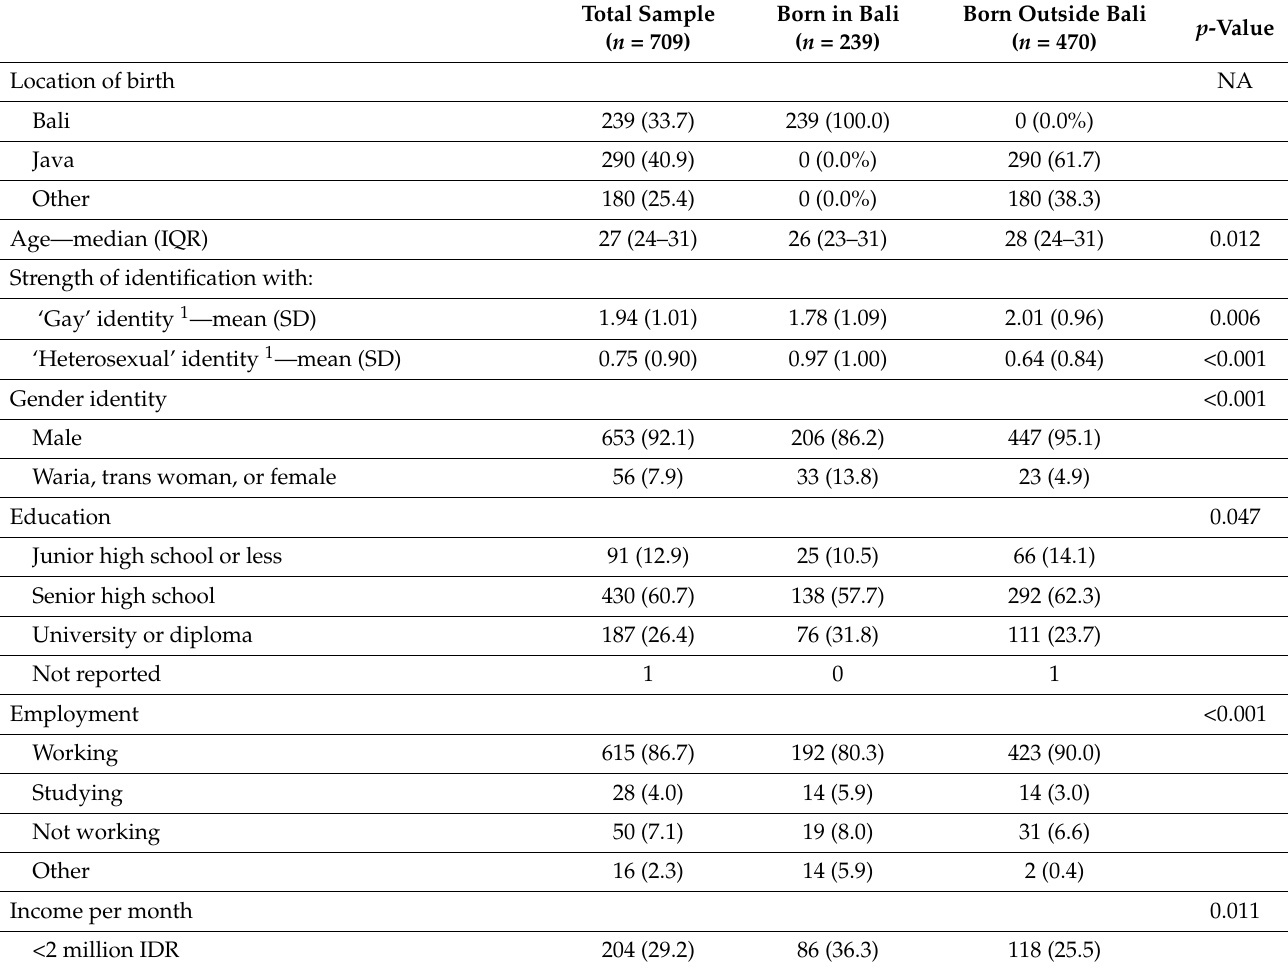
Table 1. Sample characteristics for the total sample and stratified by place of